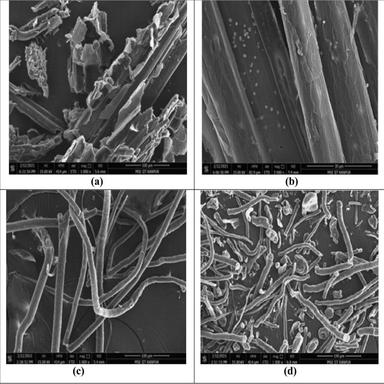
FESEM images of bamboo fibers: (a) untreated BF (b) alkali treated BF (c) acid alkali treated BF and (d) nanocellulose.